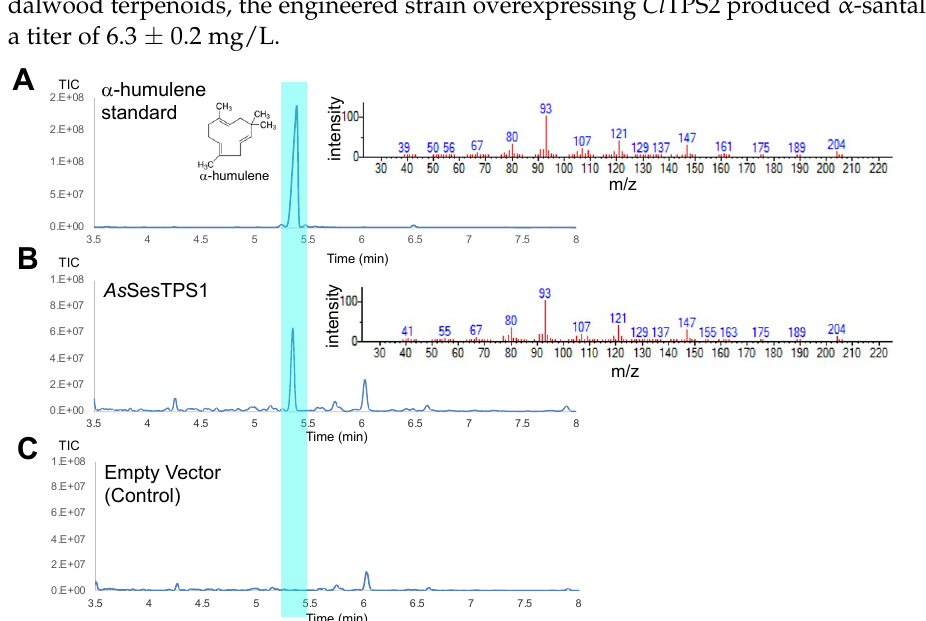
Figure 4. Total ion chromatograms (left panel) and mass spectra (right panel) obtained from GC-MS 347 analysis of an authentic standard for a -humulene ( A ) and dodecane samples from the cultivation of 348 strains FPPY005_39850 harboring pRSII426-Gal1/10-AcHS1 ( B ) and FPPY005_39850 harboring the 349 empty vector pRSII426-Gal1/10 ( C ).